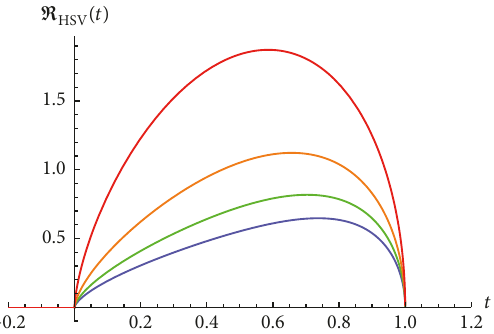
Figure 2: Entanglement velocity as a function of time for different values of 𝑑 . The colors blue, green, red, and orange represent 𝑑 = {5,4,3, 2} , respectively. We have set 𝜃 = 0.1 , 𝑧 = 1.5 , and 𝑡